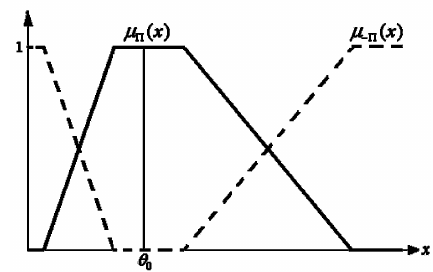
Fig. 2. H is accepted with 0